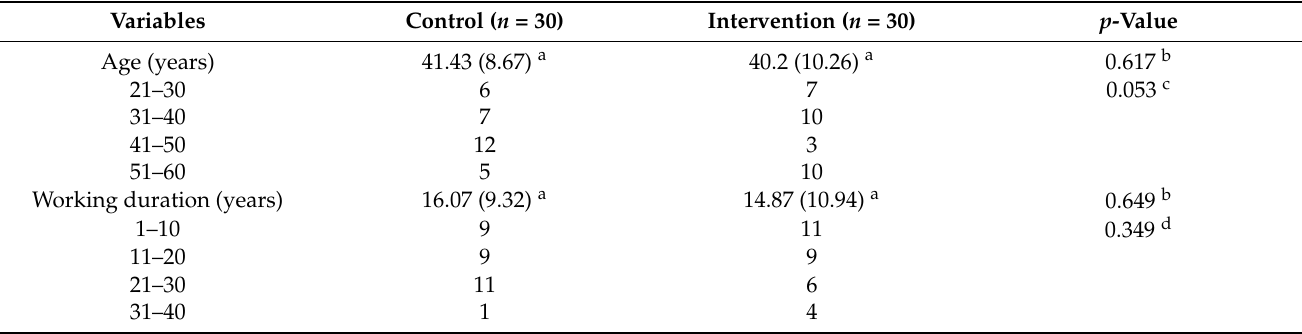
Table 2. Sociodemographic characteristics and perceived hearing status of study